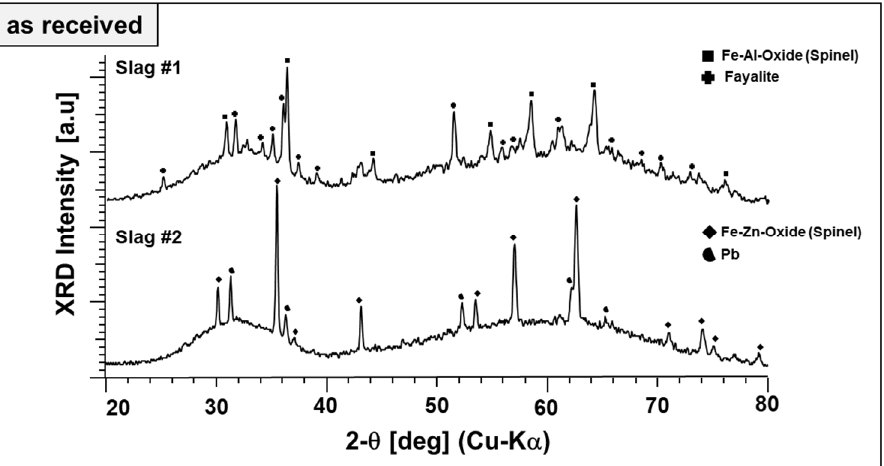
Figure 2. XRD diffractograms of as-received slags.